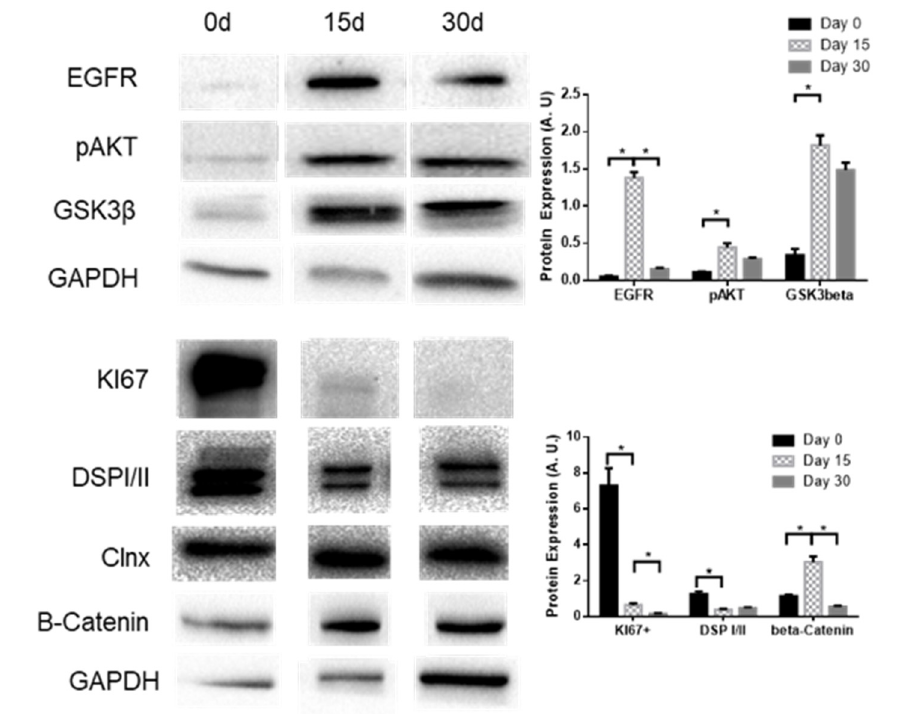
Figure 7. Expression levels of EGFR, pAKT, and GSK3 β during BCi differentiation. Representative WB of EGFR, pAKT, GSK3 β , Ki-67, DSPI/II, and β -catenin expression in BCi cells during differentiation. Calnexin and GAPDH were used as loading control. Data is normalized to loading control and showed as arbitrary units (A.U.; n = 3, unpaired t -test, * is p < 0.05).